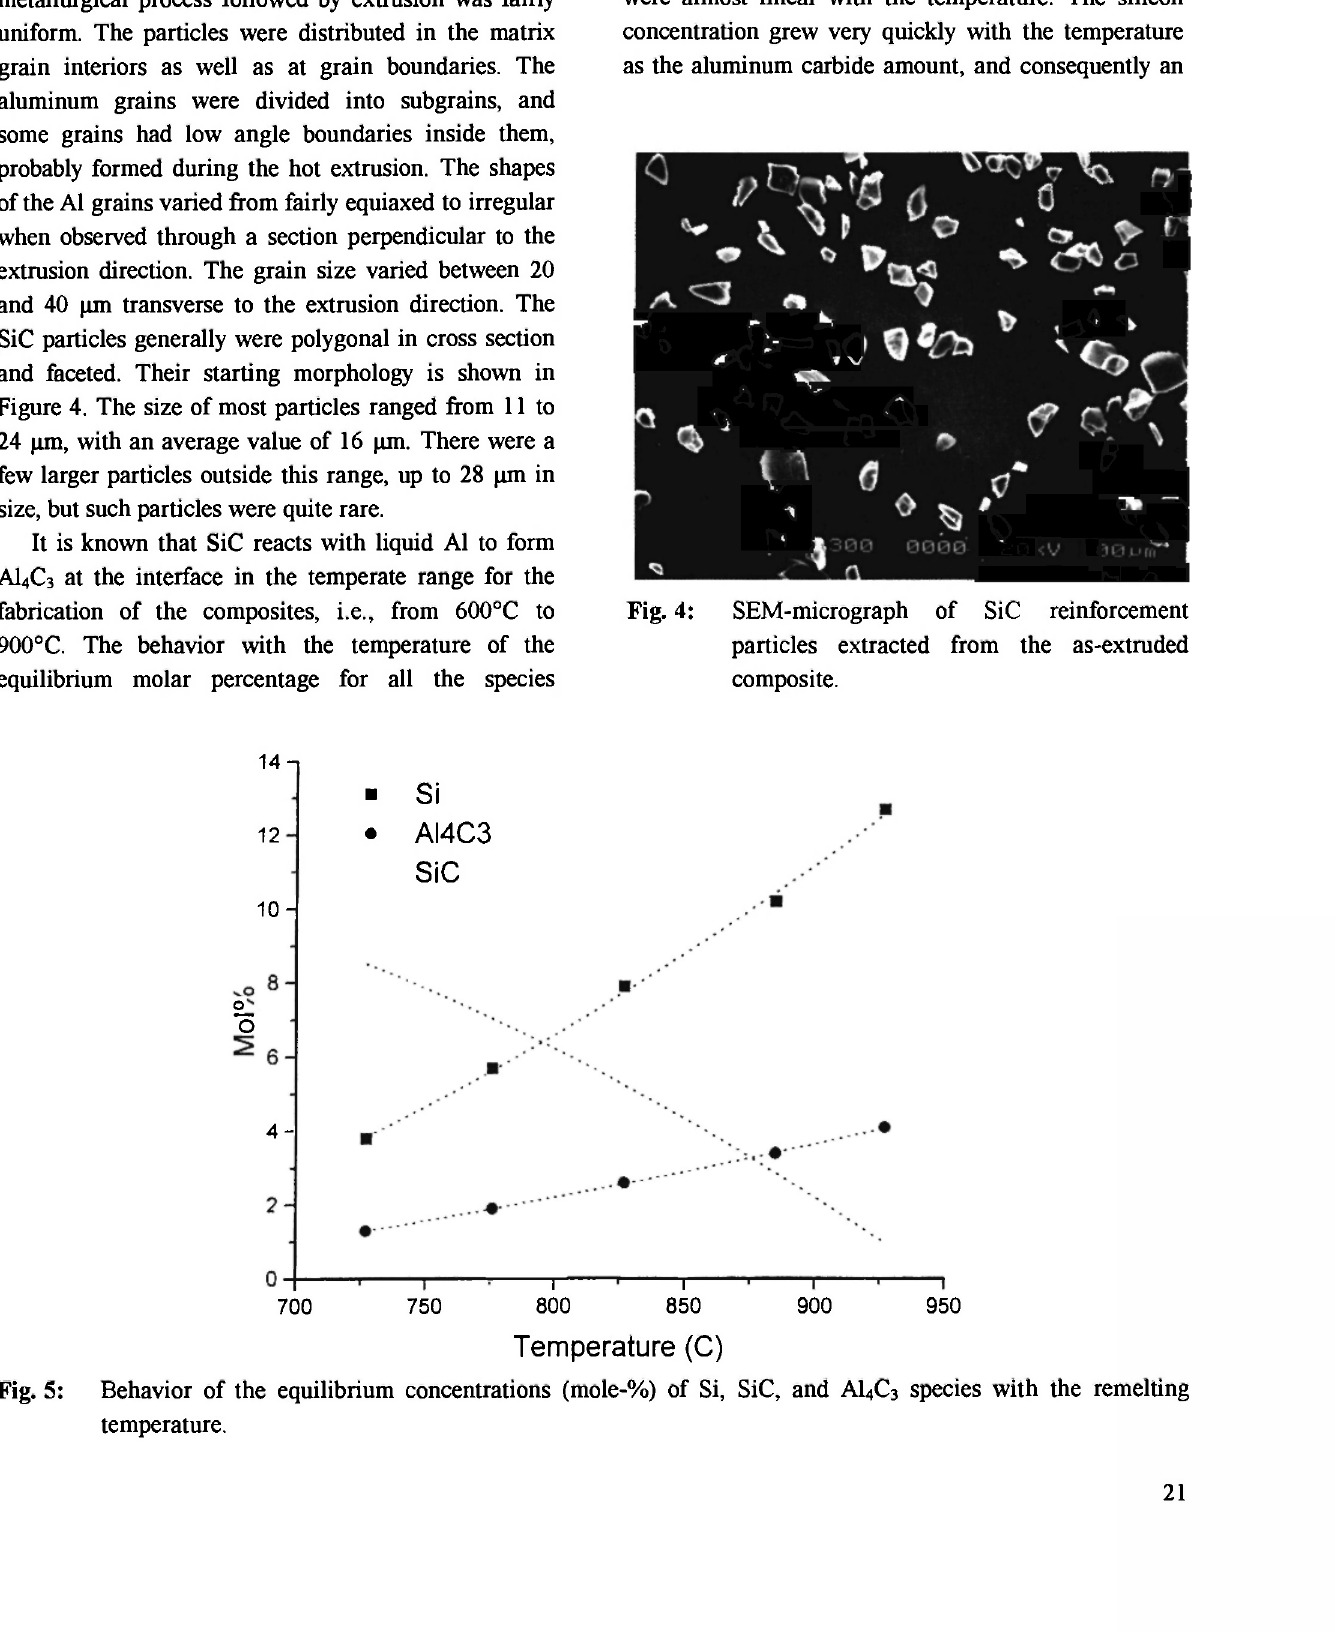
Behavior of the equilibrium concentrations (mole-%) of Si, SiC, and A1 4 C 3 species with the remelting Fig. 5: